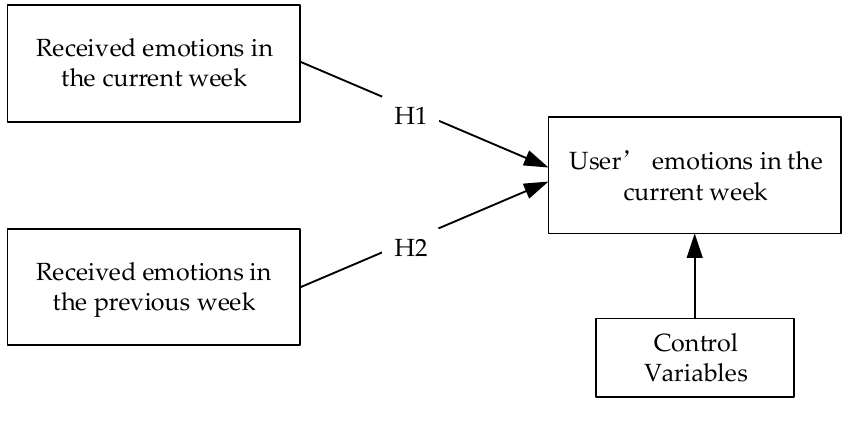
Figure 1. Research model.